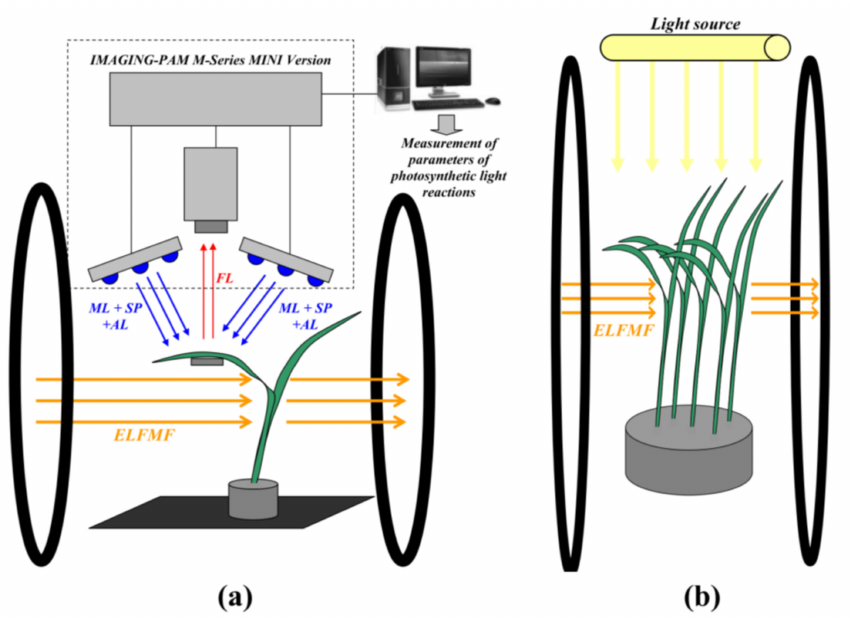
Figure 1. ( a ) Schema of plant localization in experiments with simultaneous action of artificial extremely low frequency magnetic field (ELFMF) and measurements of parameters of photosynthetic light reactions using IMAGING-PAM M-Series MINI Version. ML measuring light, SP saturation pulse, and AL actinic light. Blue light (450 nm) was used for ML, SP, and AL. FL is chlorophyll fluorescence. ( b ) Schema of localization of plants in experiments with chronic action of ELFMF. Luminescent lamps FSL YZ18RR were used as a light source for growth. Wheat plants were